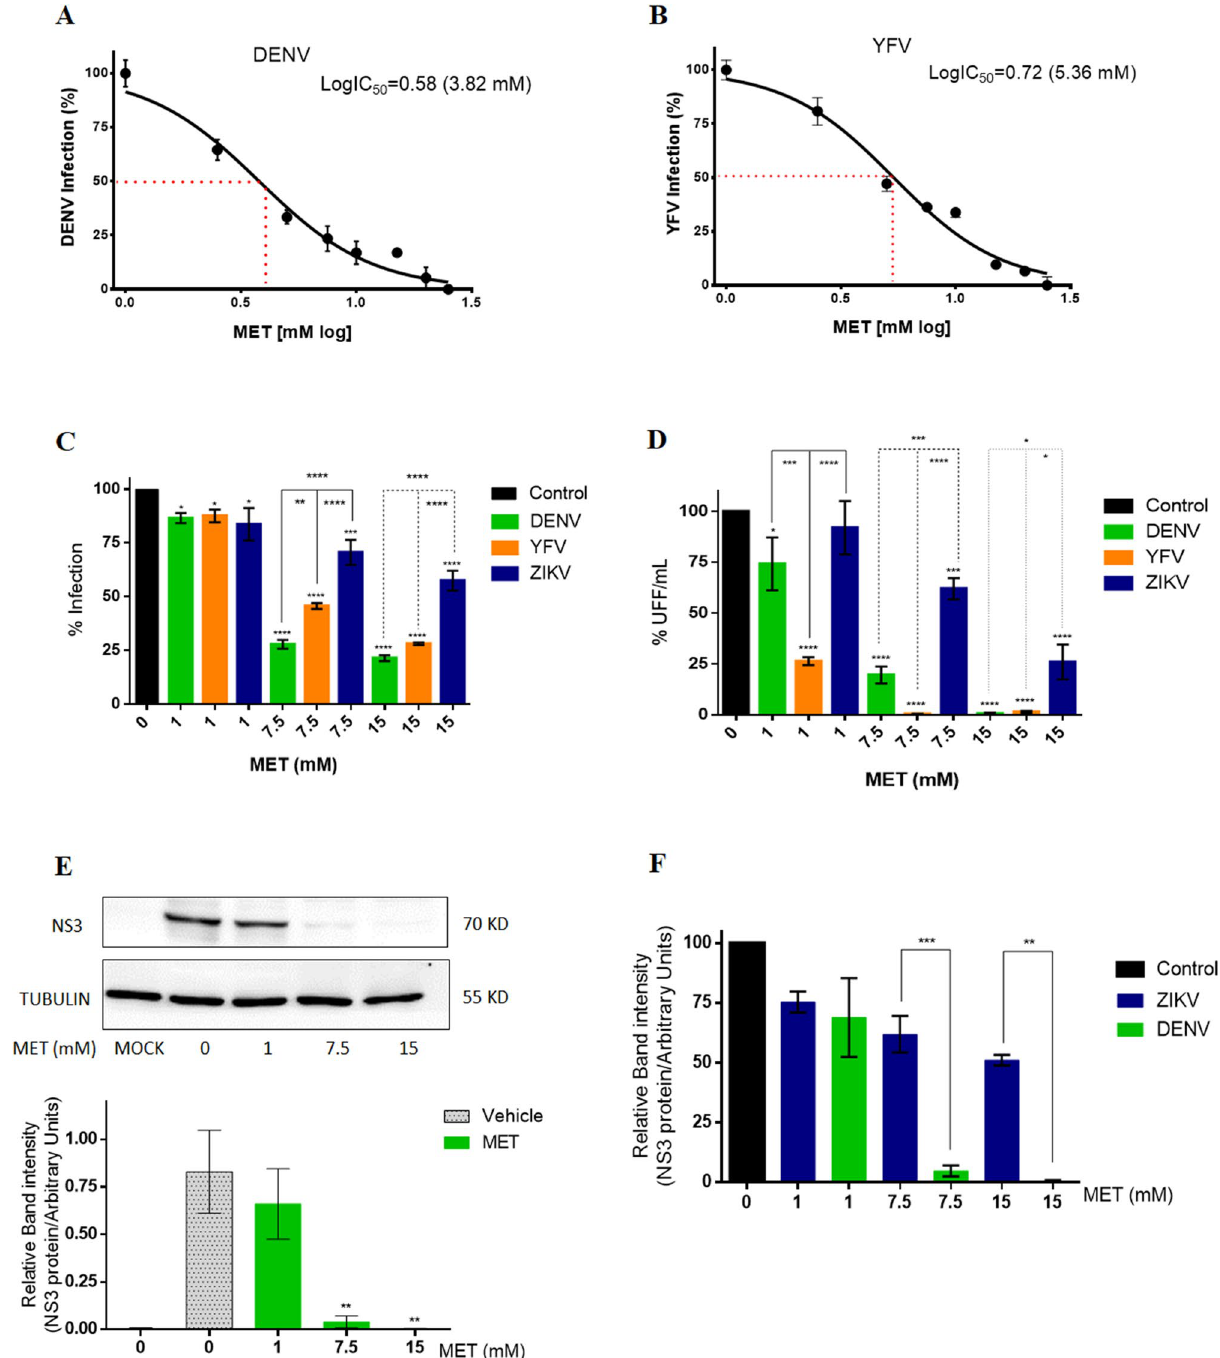
Figure 3. Effect of MET in DENV, YFV, and ZIKV infection. The CC 50 of MET for ( A ) DENV and ( B ) YFV was calculated in Huh-7 cells. The reduction of viral infection by MET was evaluated by flow cytometry, and the IC 50 was estimated by linear regression analysis. ( C ) Percentage of infection and ( D ) viral yield of DENV, YFV, and ZIKV in the presence of different concentrations of MET (1,7.5,15 mM) for 24 h. The cells were analyzed by flow cytometry and the viral titers of the collected supernatants analyzed by focus forming units (FFU) assay. ( E ) The DENV NS3 protein levels were analyzed by western blot in Huh-7 cells after treatment with different concentrations of MET. The densitometric analysis is shown. ( F ) Densitometric analysis comparing the DENV and ZIKV NS3 protein levels after treatment with different concentrations of MET. The results are presented in percentages considering as 100% the untreated infected cells (Control). The results were plotted with Graph Pad Prism software version 6.0. The graphs represent the means ± SD of n = 3 independent experiments realized by duplicated. *p = 0.0332, **p = 0.0021, ***p = 0.0002 ****p <